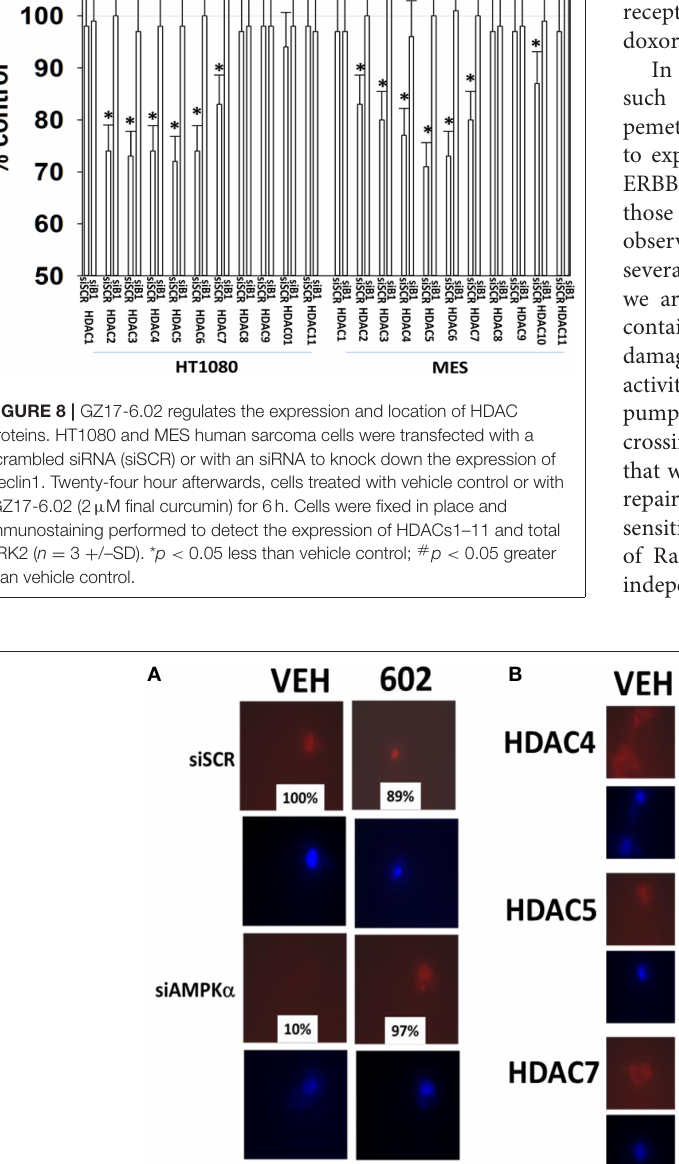
Frontiers in Oncology |